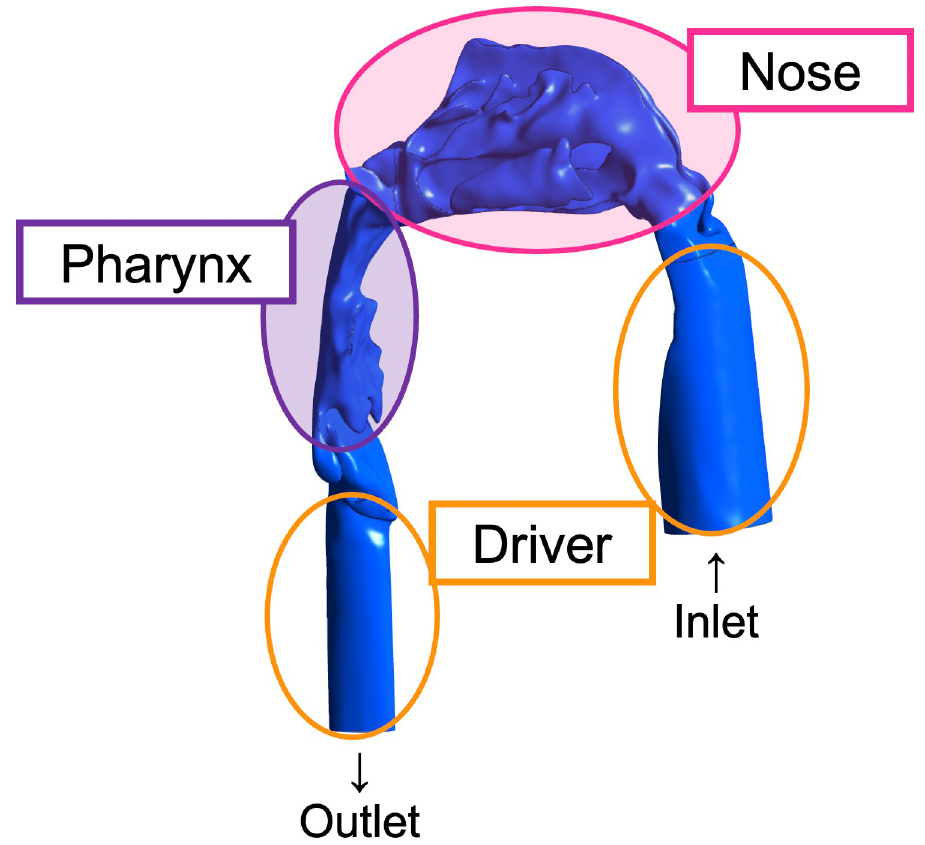
Fig 2. Development of the driver. Three-dimensional model of the nasal airway with the tubes projecting from the nostrils and subglottis indicating the “driver” region (encompassed by orange circles). The area surrounded by the pink oval is the nose area. The area surrounded by the purple oval is the pharynx